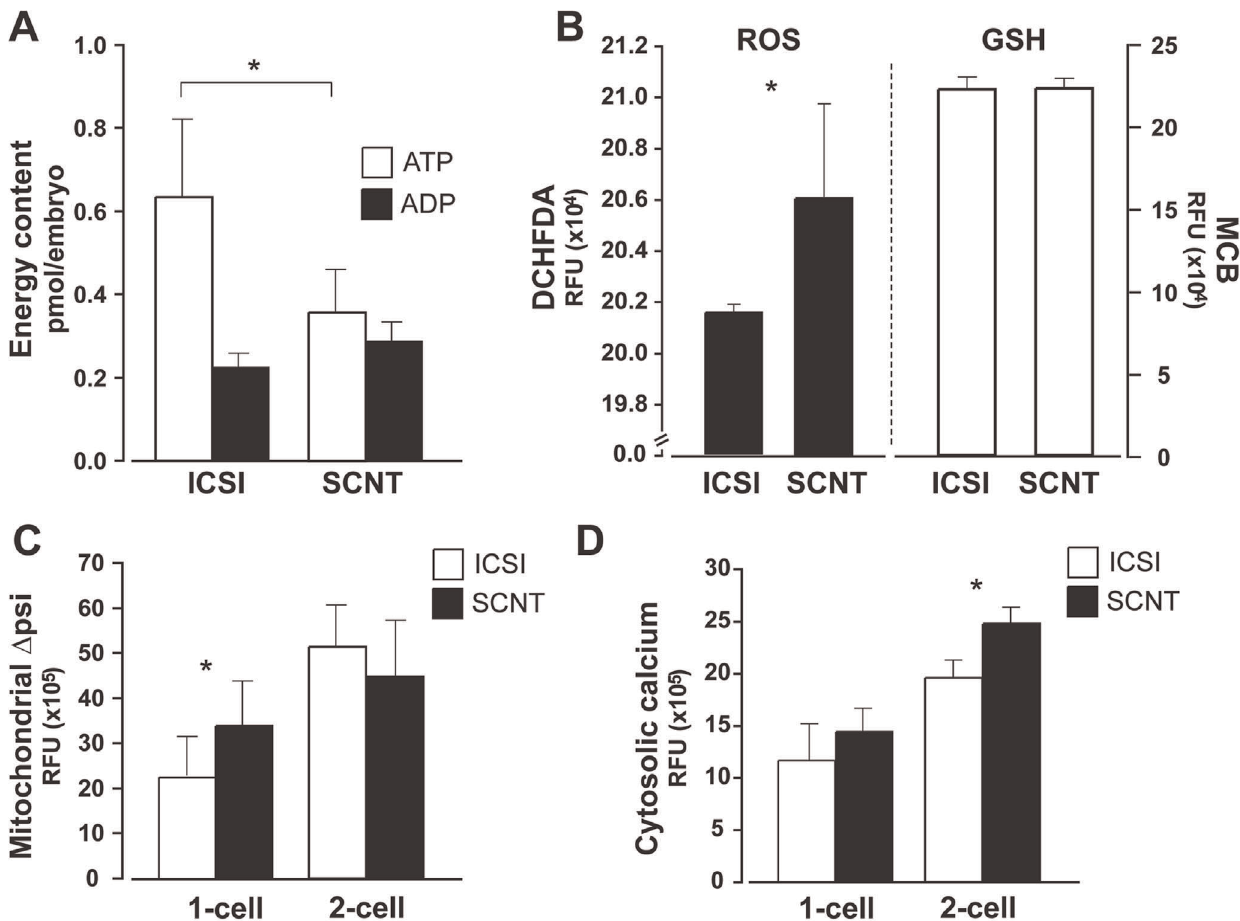
Figure 6. Metabolic disturbances after SCNT. (A) Energy (ATP and ADP) content decreases in SCNT at the 4-cell stage, compared to ICSI embryos (significant difference for ATP; t-test, p =0.008). (B) Levels of reactive oxygen species (ROS) are increased in 4-cell SCNT (t-test, p =1.0E-06), as measured by DCHFDA. At the same stage, cellular antioxidant capacity (measured as reduced glutathione levels, with MCB) is similar for SCNT and ICSI embryos. (C) Increased TMRM signal indicates higher mitochondrial membrane potential after SCNT (t-test, p =0.007), while (D) cytosolic calcium (measured with Fura-2 AM) is significantly increased in 2-cell SCNT (t-test, p =1.4E-06).